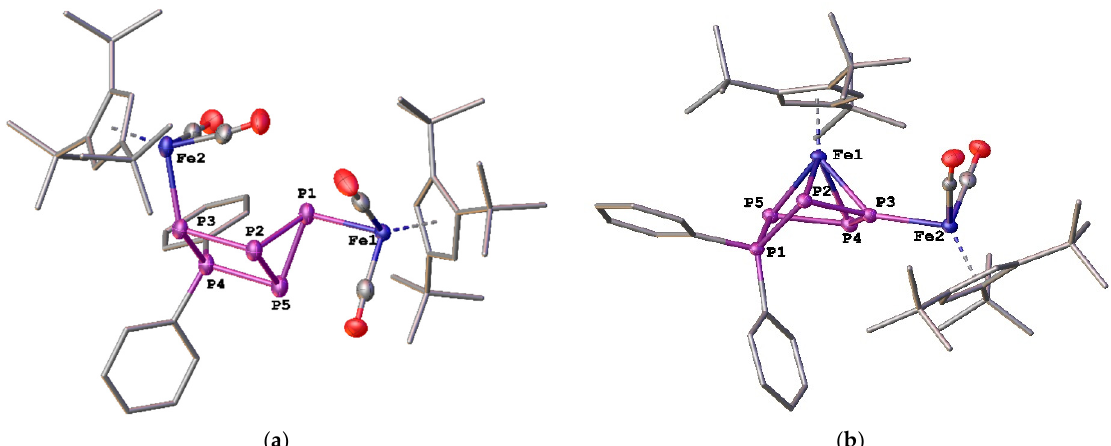
Figure 1. Cationic parts of the molecular structures of 3a ( a ) and 4 ( b ), respectively, in the solid state. Hydrogen atoms, solvent molecules and counter ions are omitted for clarity. Selected bond lengths (Å) for 3a —Fe1-P1 2.3162(12), Fe2-P3 2.3004(15), P1-P5 2.2010(18), P2-P1 2.1971(15), P2-P5 2.2546(17), P3-P2 2.2305(15), P3-P4 2.2128(17), P4-P5 2.1974(16). Selected bond lengths (Å) for 4 —Fe1-P3 2.2925(7), Fe1-P5 2.3422(7), Fe1-P4 2.3517(8), Fe1-P2 2.3610(8), Fe2-P3 2.2567(7), P1-P52.1590(9), P1-P2 2.1761(9), P2-P3 2.1293(9), P3-P4 2.1337(9), P4-P5 2.1322(10).